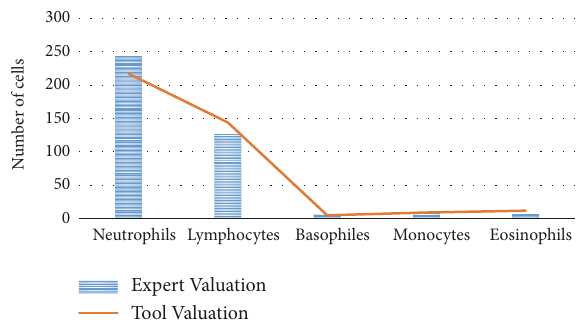
Figure 4: Comparison of results of the identification of white blood cells, carried out by the professional in hematology and the computational